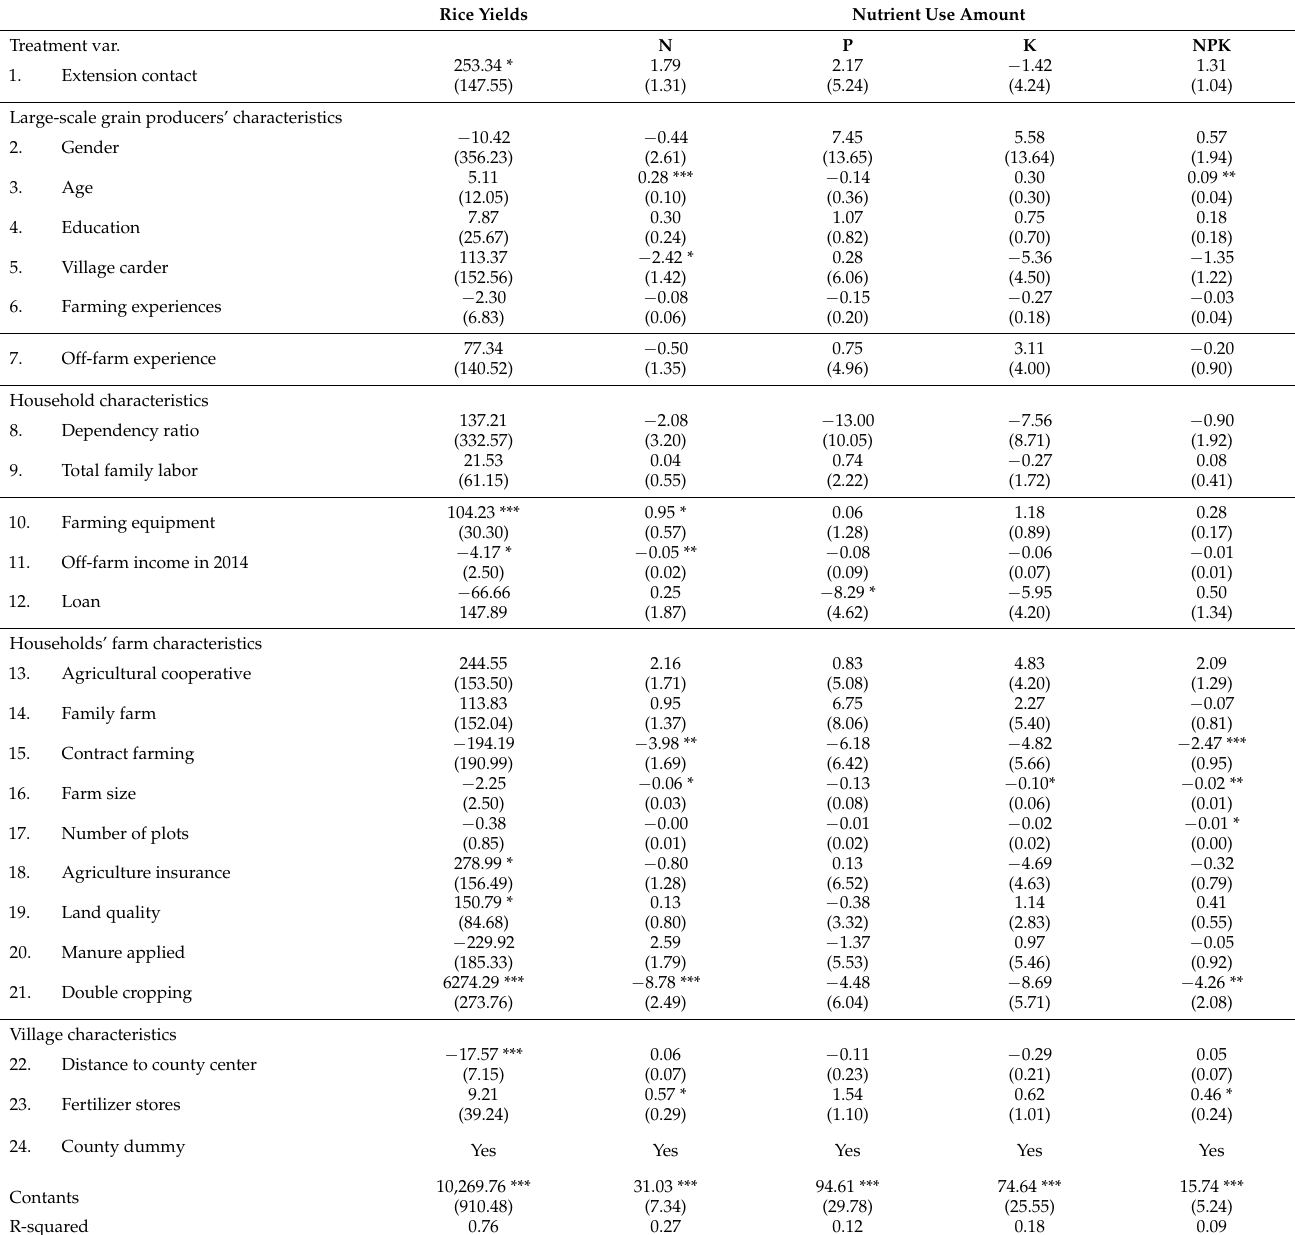
Table 6. Effect of extension contact on rice yields and nutrient use amount by OLS